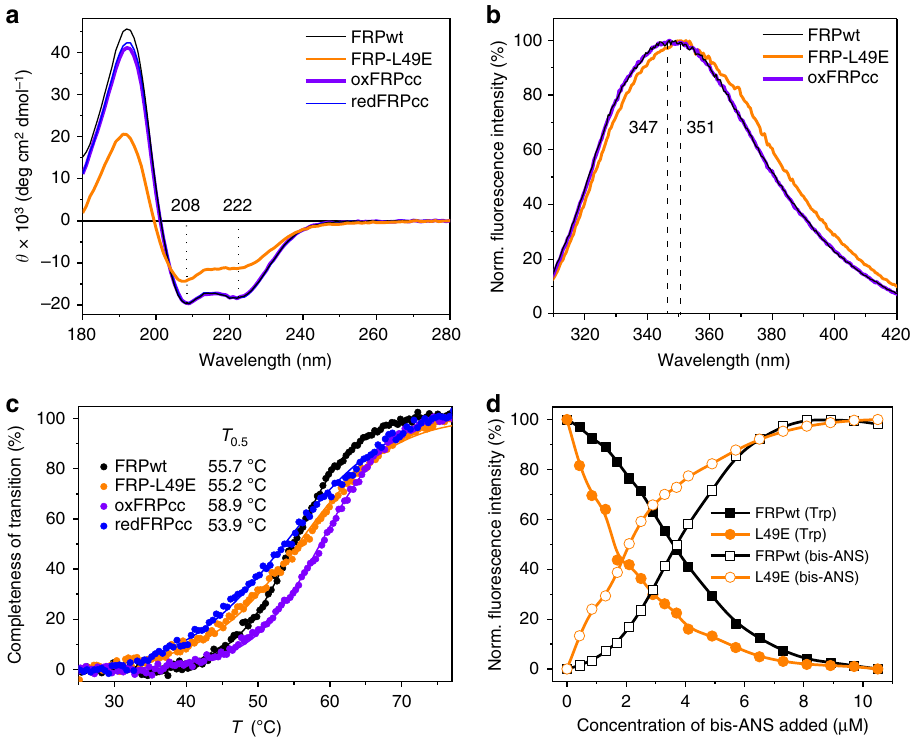
Fig. 2 Properties of the dimeric and monomeric FRP species. a Far-UV CD spectra of FRPwt, FRP-L49E, oxFRPcc, and redFRPcc (at 36 µ M). Positions of the peak minima are indicated in nm. b Intrinsic Trp fl uorescence spectra for FRPwt, oxFRPcc, and FRP-L49E (at 1.6 µ M). Positions of the peak maxima are indicated in nm. c Thermal stability of FRPwt, FRP-L49E, oxFRPcc, and redFRPcc (at 1 µ M) assessed by following changes in their Trp fl uorescence (excitation 297 nm; emission 382 nm) upon heating at a constant 1 °C min − 1 rate. Corresponding half-transition temperatures are indicated. d Titration of FRPwt (1 µ M; black curves) and FRP-L49E (1 µ M; orange curves) by bis-ANS (0 – 10.5 µ M) followed by changes of either FRP Trp fl uorescence (excited at Fig. 2 for raw spectra Table 1 Secondary structure elements estimated using Dichroweb 50 FRPwt FRP – L49E